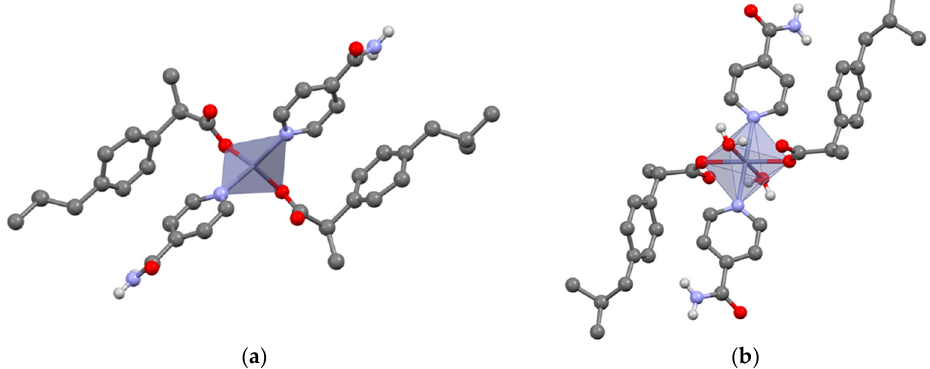
Figure 2. Monomers in Zn(IBU) 2 (INC) 2 ( a ) and Zn(IBU) 2 (INC) 2 (H 2 O) 2 ( b ); H CH omitted for clarity.